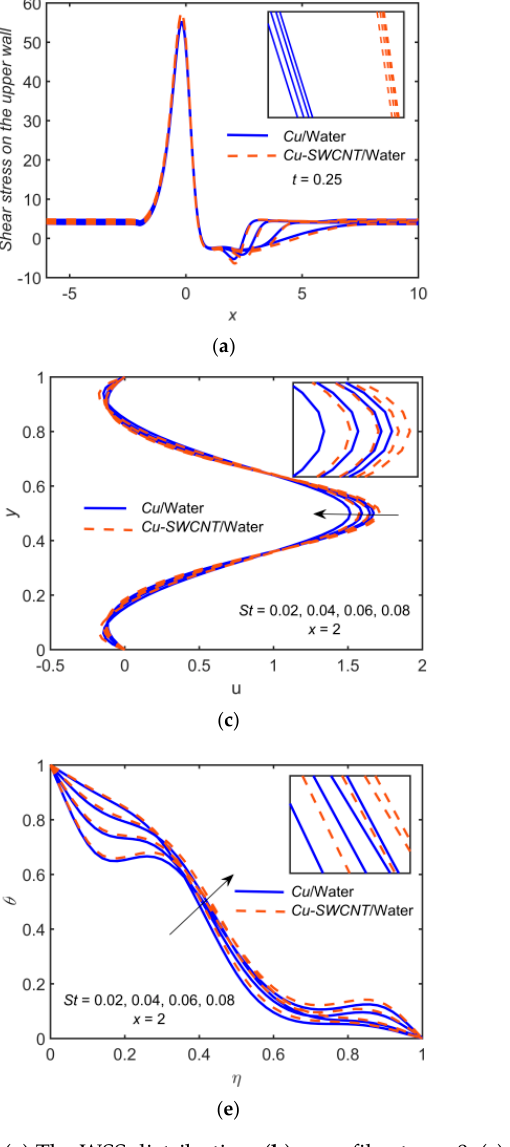
Figure 4. ( a ) The WSS distribution, ( b ) u profile at x = 0, ( c ) u profile at x = 2, ( d ) θ profile at x = 0, ( e ) θ profile at x = 2, and ( f ) ϕ profile at x = 0 for distinct values of St